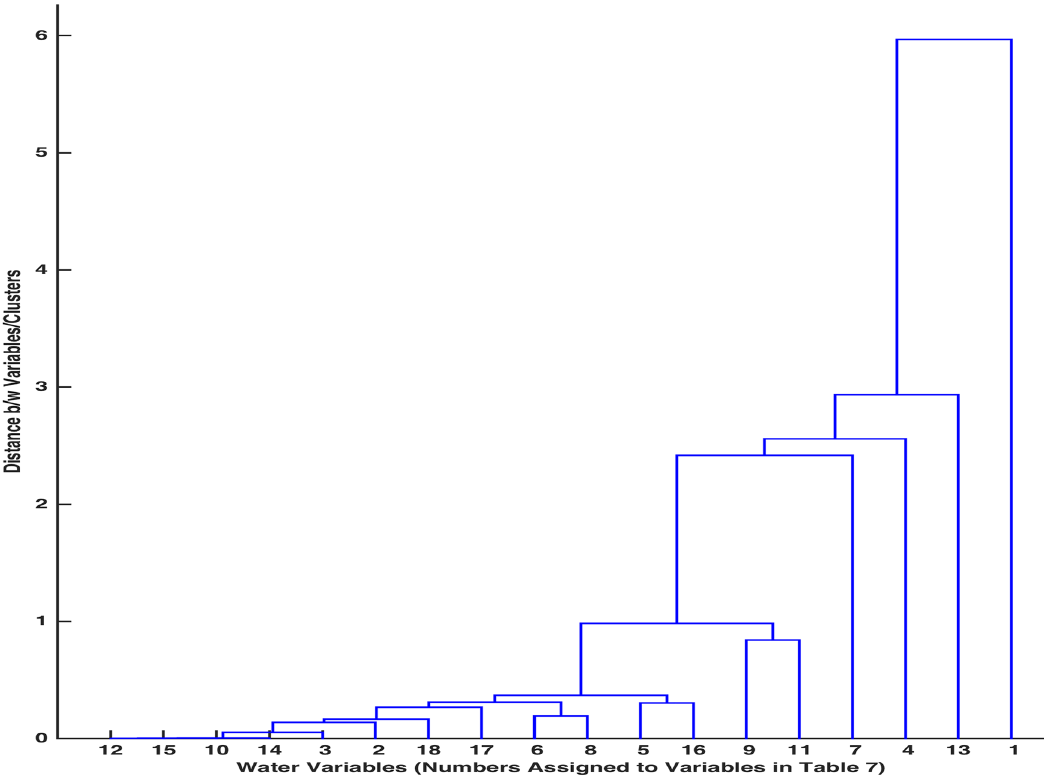
Figure 15. Dendrogram for clusters.